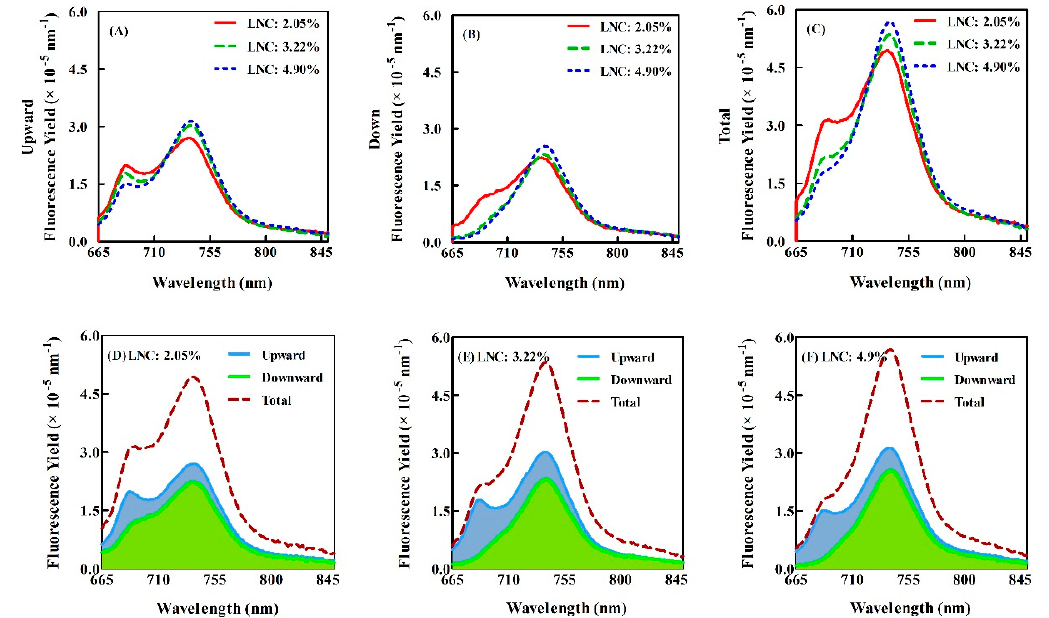
Figure 4. The upward, downward and total SIF yield spectra under different nitrogen levels in Experiment 2. Top row, each figure comparing different LNC contents for a given SIF component ( A – C ). Bottom row, each figure comparing the different SIF contributions for a given LNC ( D – F ).